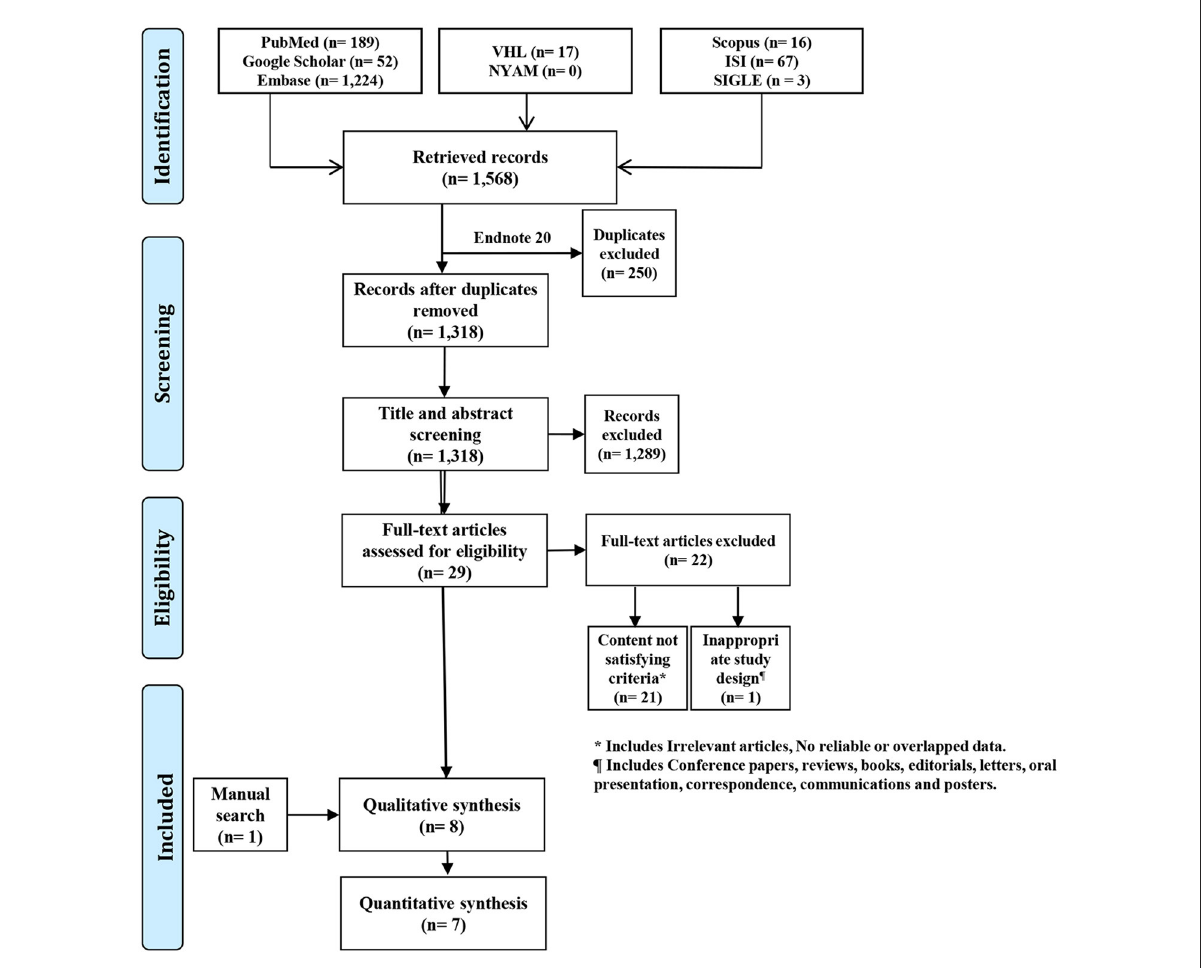
FIGURE1 PRISMA flow